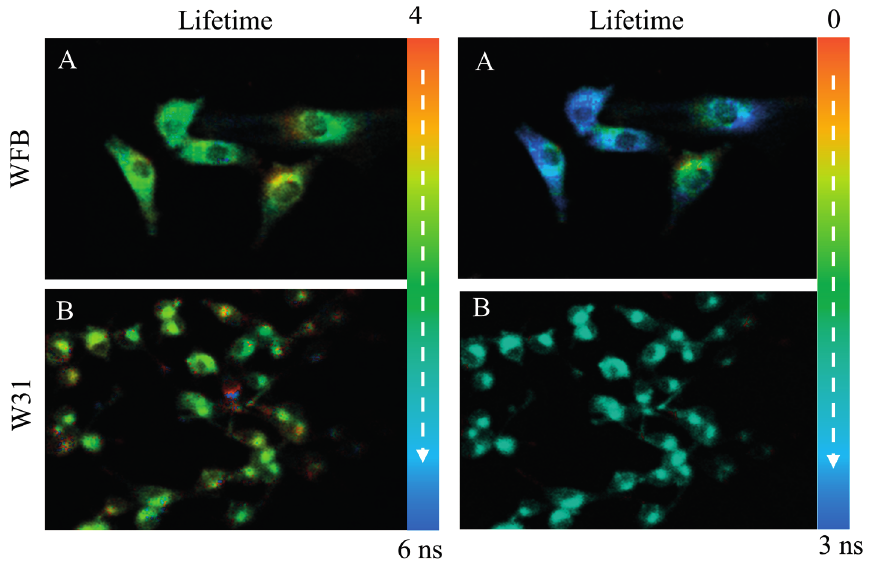
Figure 7. Fluorescence lifetime images of TPS in WFB cells ( upper ) and in W31 cells ( lower ) in the time range of 4–6 ns ( left ) and in the time range of 0–3 ns ( right ). These images correspond to the ones shown in Figure 4A,B, respectively. Pseudocolor is used for the lifetime images to show the value of the fluorescence